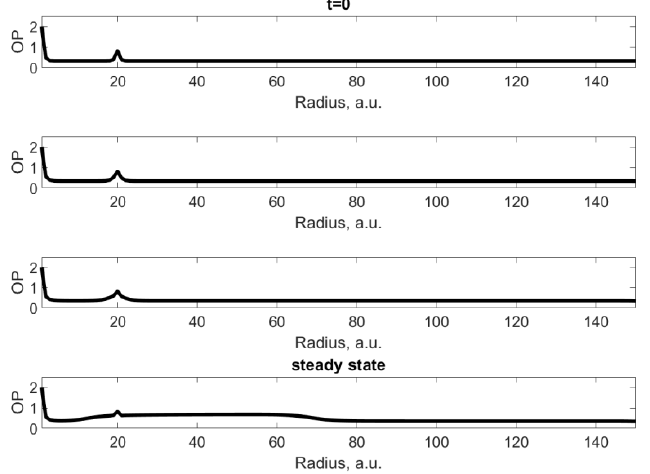
Figure 2. Dynamics of order parameter distribution depending on time (increasing from top to the bottom) in the direction of the defect. The bottom plot corresponds to the steady state.